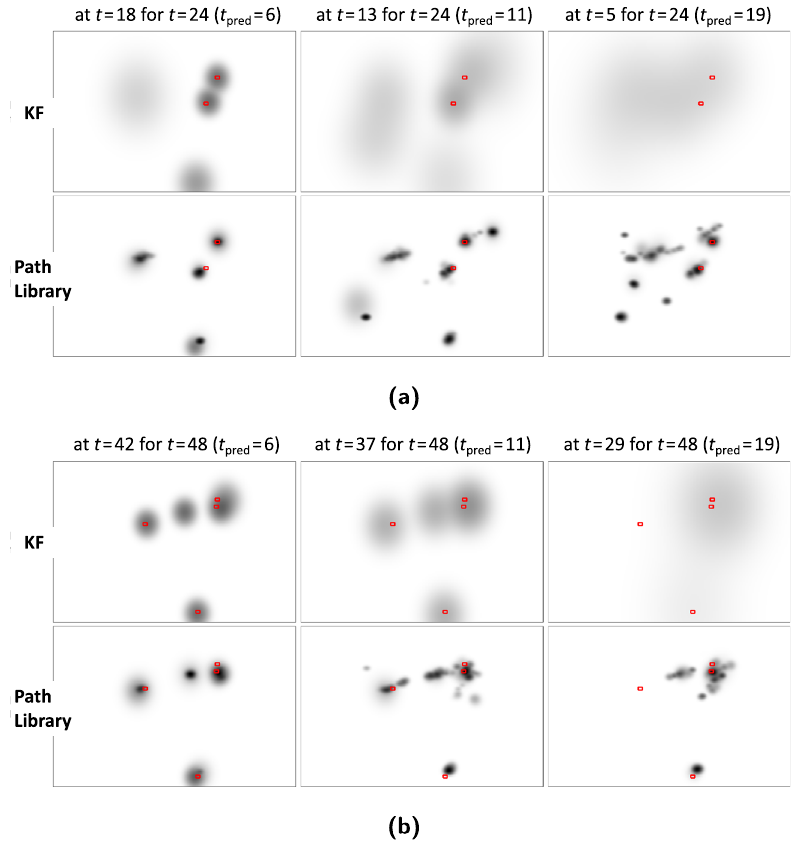
Figure 9: Real data examples: comparing area occupancy predictions by KF ( top ) and path library ( bottom ) . The red markers give the locations of objects at the end of prediction: at t 24 = s in Example ( a ) and at t 48 = s in Example ( b ) . The gray clouds indicate the predicted probability of the location being occupied by the agent. The predictions were made using observations obtained 6 s ( left ) , 11 s ( middle ) , and 19 s ( right ) earlier, respectively. ( a ) Predictions for t 24 s = . ( b ) Predictions for t 48 s =